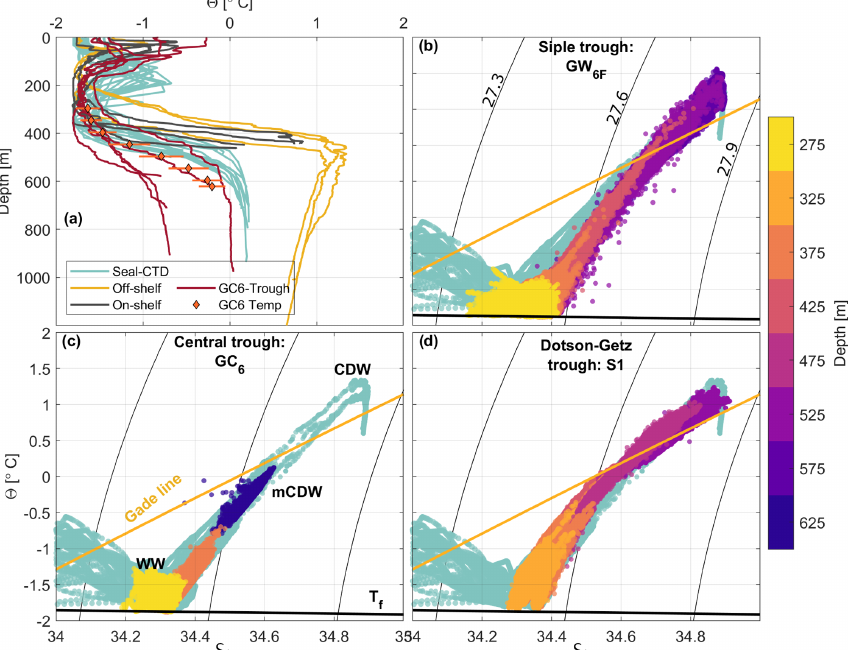
Figure 3. (a) Temperature profiles taken by ship (red, black, yellow) and the seal (turquoise, see Fig. 1a, b for locations). Orange diamonds and lines show the mean temperature and standard deviation recorded by each instrument on GC6. (cid:50)S A diagrams for (b) GW 6F in the Siple trough, (c) GC 6 in the GC 6 Trough between Siple and Carney Islands, and (d) S1 in the Dotson–Getz Trough (see Fig. 1a for locations), color- coded by the depth of moored instruments, and with the CTD stations and seal dives from Fig. 1a marked in turquoise in the background. Four outliers are removed from S1. The σ density contours (thin black lines), the Gade line (yellow), surface freezing temperature T f (thick black line), and characteristic water masses are labeled (WW: Winter Water, mCDW: modified Circumpolar Deep Water, CDW: Circumpolar Deep